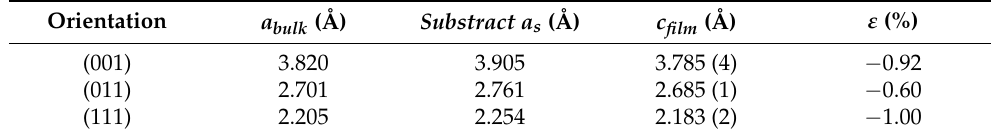
Table 2. Out-of-plane ( c film ) and biaxial strain ( ε ) of the LSCO epitaxial thin film. The pseudocubic lattice parameters of bulk LSCO are a bulk ≈ 3.82 Å, 2.701 Å, and 2.205Å, respectively. Orientation